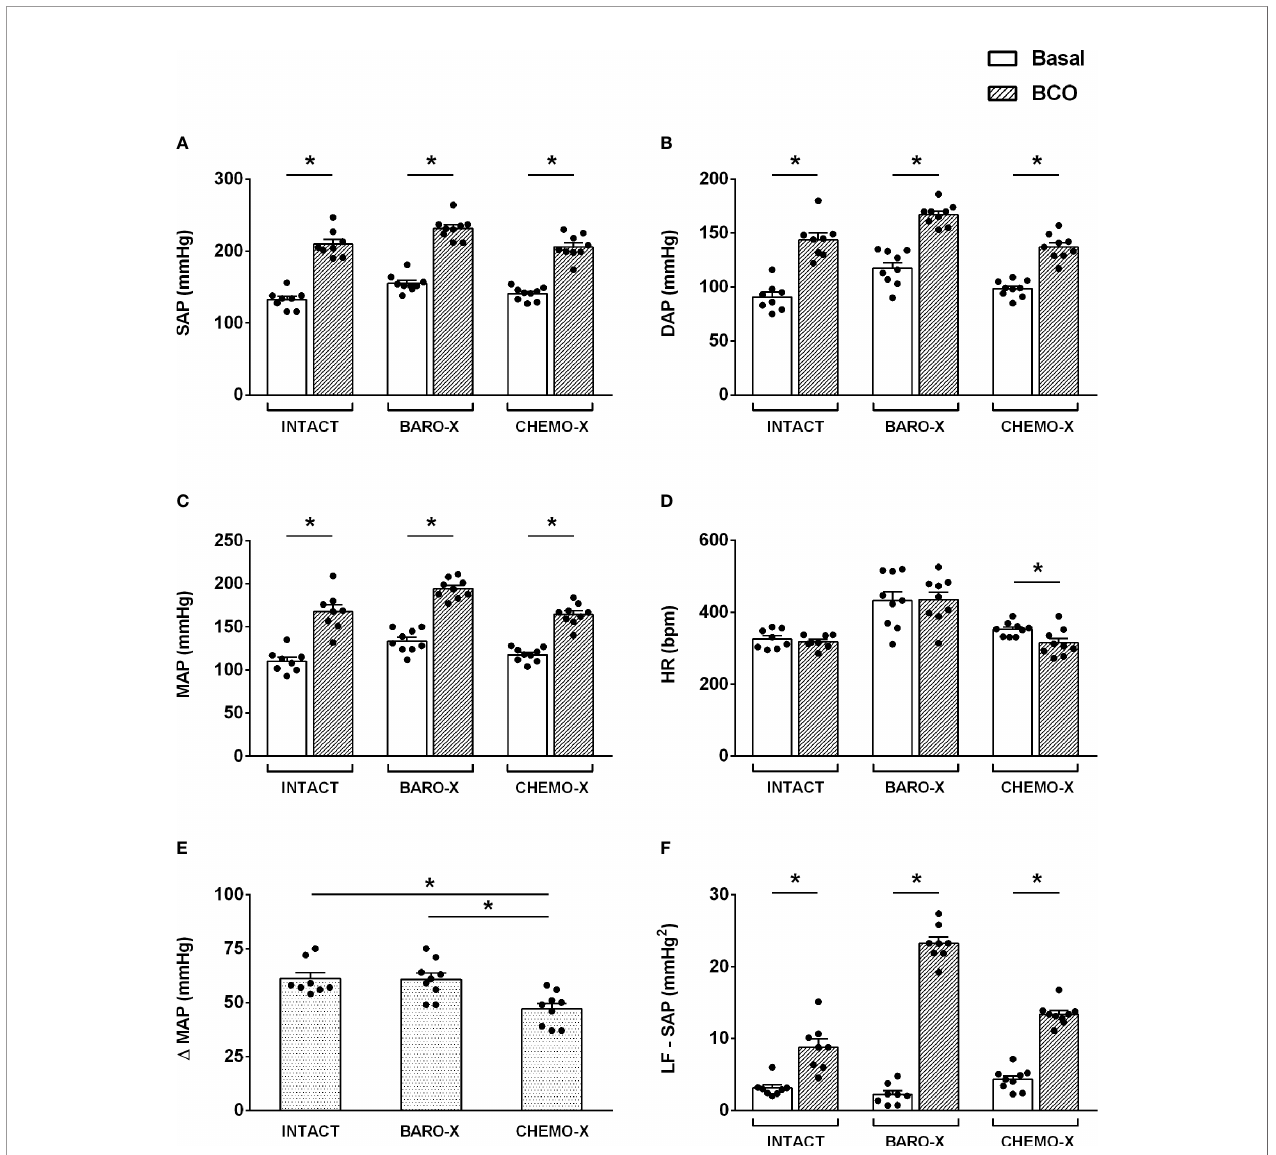
FIGURE 1 | Hemodynamic and autonomic responses to bilateral carotid occlusion (BCO) in intact animals and with denervation of baroreceptors (BARO-X) or chemoreceptors (CHEMO-X). SAP, systolic arterial pressure (A) ; DAP, diastolic arterial pressure (B) ; MAP, mean arterial pressure (C) ; HR, heart rate (D) ; D MAP: the difference between basal and BCO values of MAP (E) ; LF-SAP: low frequency band in the spectrum of the systolic arterial pressure (F) . Panels (A – D) : basal period (white bars) and BCO peak response period (period of 5 s within the peak response during BCO; gray bars). Panel (F) : basal (white bars) and BCO period (period of 20 s of the BCO plus the next 40 s after BCO ending; gray bars). Bars represent mean ± SEM. *p <